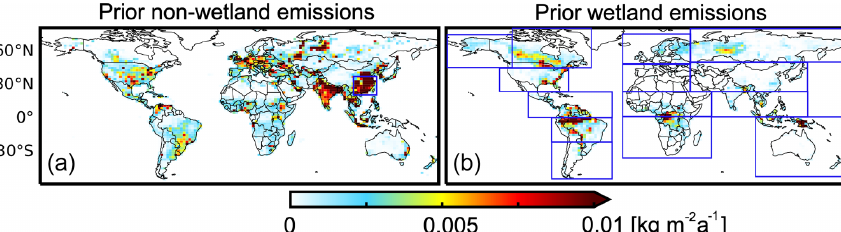
Figure 4. Spatial distribution of prior methane emissions in 2019. The blue box over China in panel (a) indicates the region used for seasonality analysis in Fig. 8. The blue boxes in panel (b) indicate the 14 subcontinental regions of Y. Zhang et al. (2021) for which monthly wetland emissions are